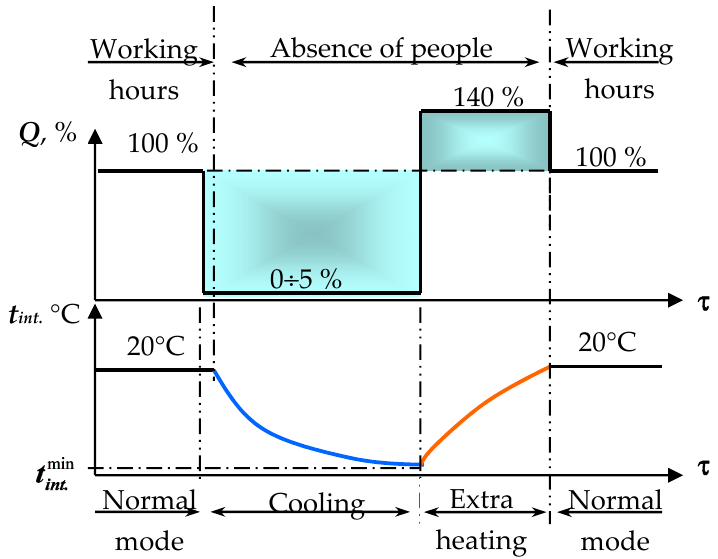
Figure 1. The principle of two-stage climate control ( Q —relative power of the heating system; τ —time of day; t int. —internal air temperature).